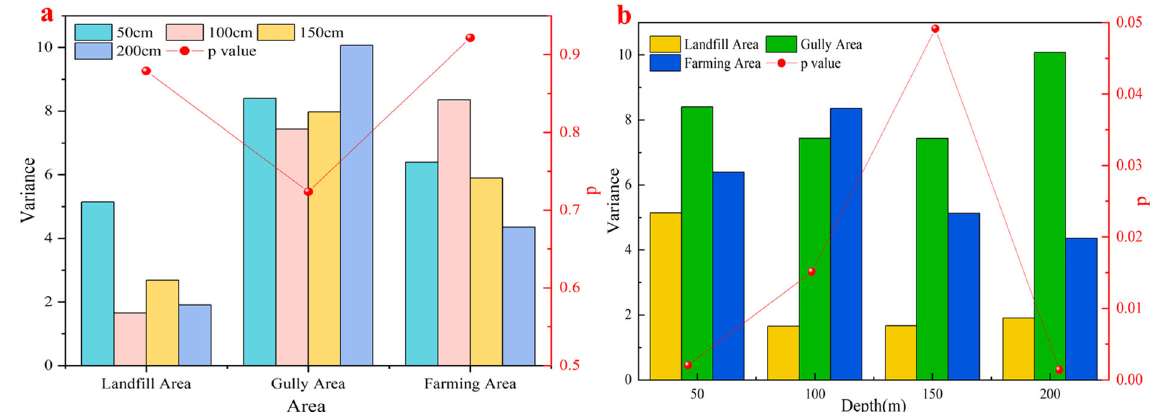
Figure 4. ANOVA of soil moisture at different depths in the same area ( a ) and different areas at the same depth ( b ). The results of the Kolmogorov–Smirnov (K–S) normal distribution test for each group of data show that the soil moisture data in the gully head landfill area, the gully area, and the highland farming area were normally distributed at a significant level of 95%. As can be seen from Table 2, the coefficient of variation at less than 50 cm depth is greater than at other depths because this depth is near the surface where the soil moisture is easily influenced by various factors and the disturbance is greater. The variation coefficients of the average soil moisture in the other depths were not large (none of them exceeded 20%) in the study area, which might be caused by the small area and similarity of vegetation type, hydrology, and micro ‐ ecological environment. The variation coefficient was the smallest in the gully head landfill area, perhaps because the soil was refilled rather than formed by deposition, and there was no vegetation cover on the surface. Compared with the undisturbed soil in the gully area and highland farming area, the disturbance factor was less, so the variation coefficient was smaller (9.52%). Compared with the complexity of moisture variation in the gully area and the highland farming area, the soil moisture variation in the gully head landfill area is mainly related to rainfall, soil texture, and evapotranspiration.